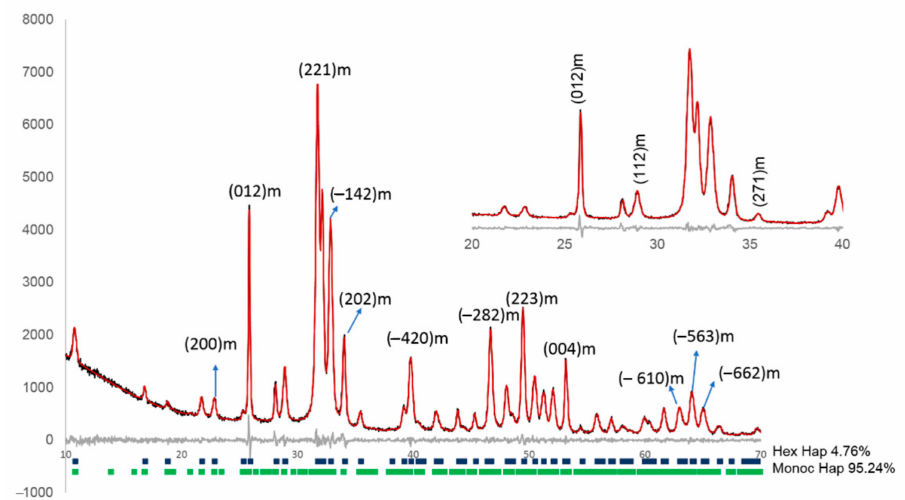
Figure 4. Rietveld refinement plot showing the goodness of fit obtained between the measured and calculated intensities for the HAp sample synthesized at pH 10.